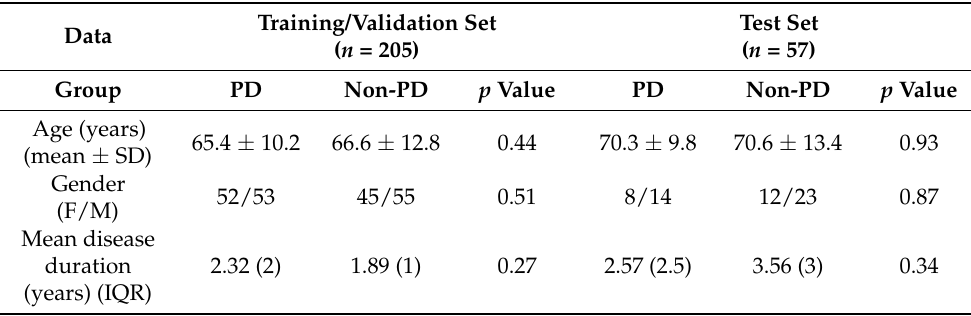
Table 1. Demographic characteristics of the